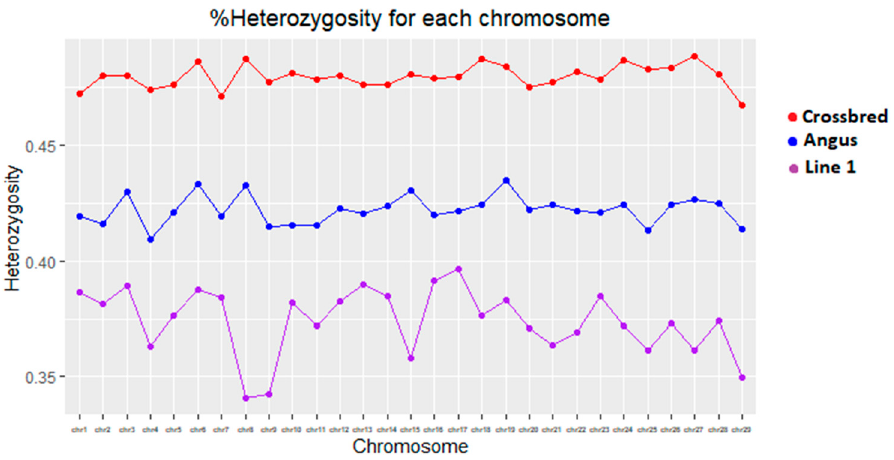
Figure 2. Percentage of heterozygosity per chromosome using SNP information for all breeds used in the study .